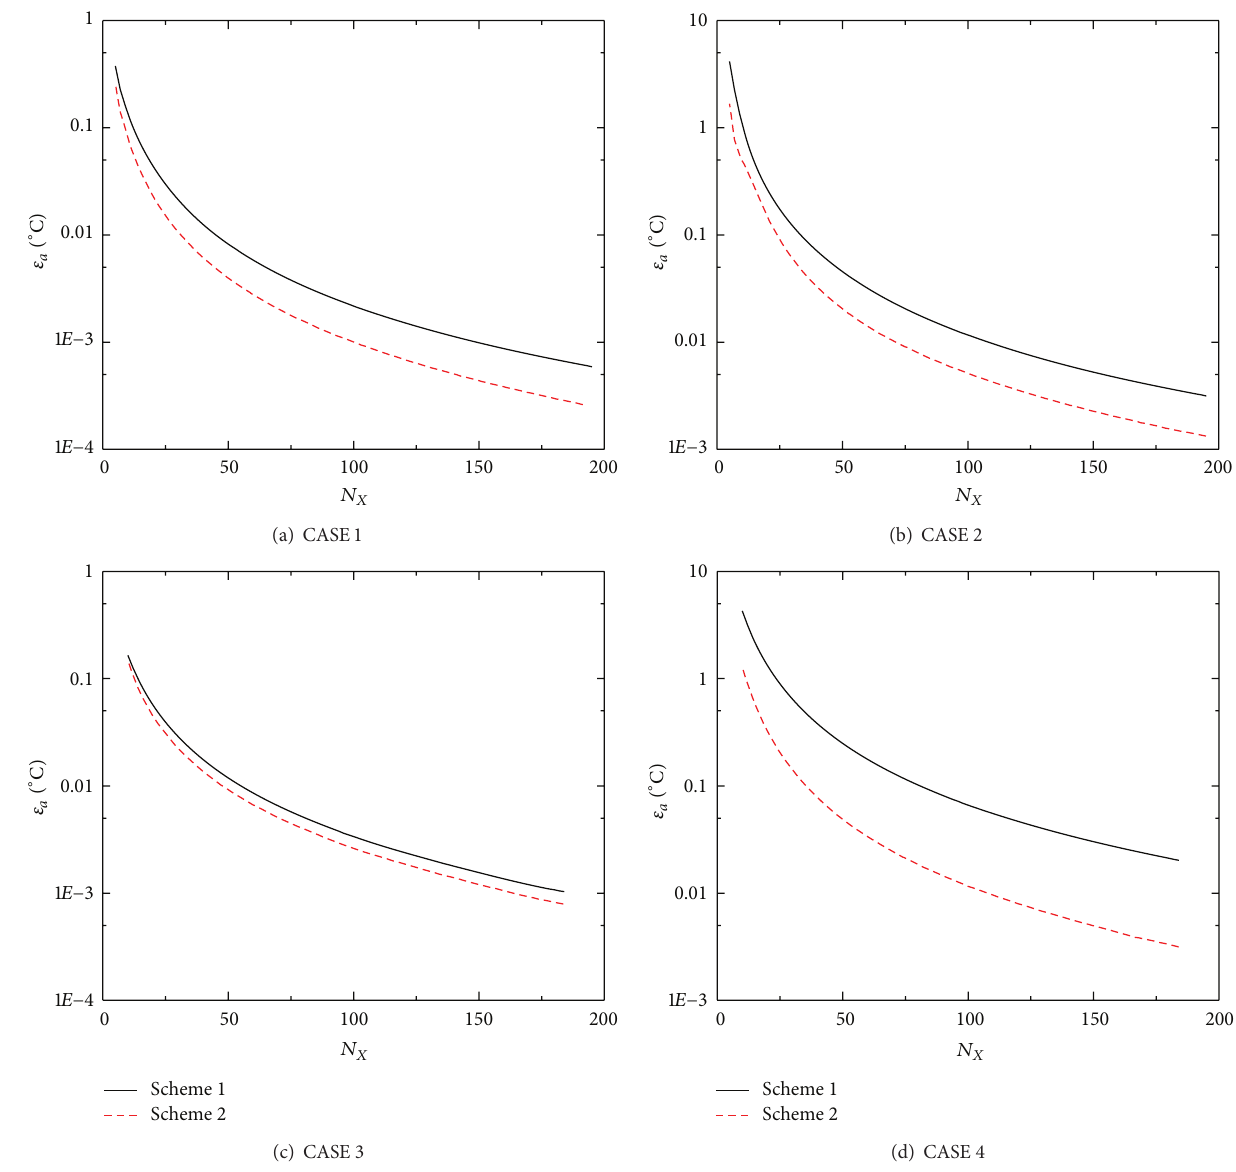
Figure 6: Average absolute